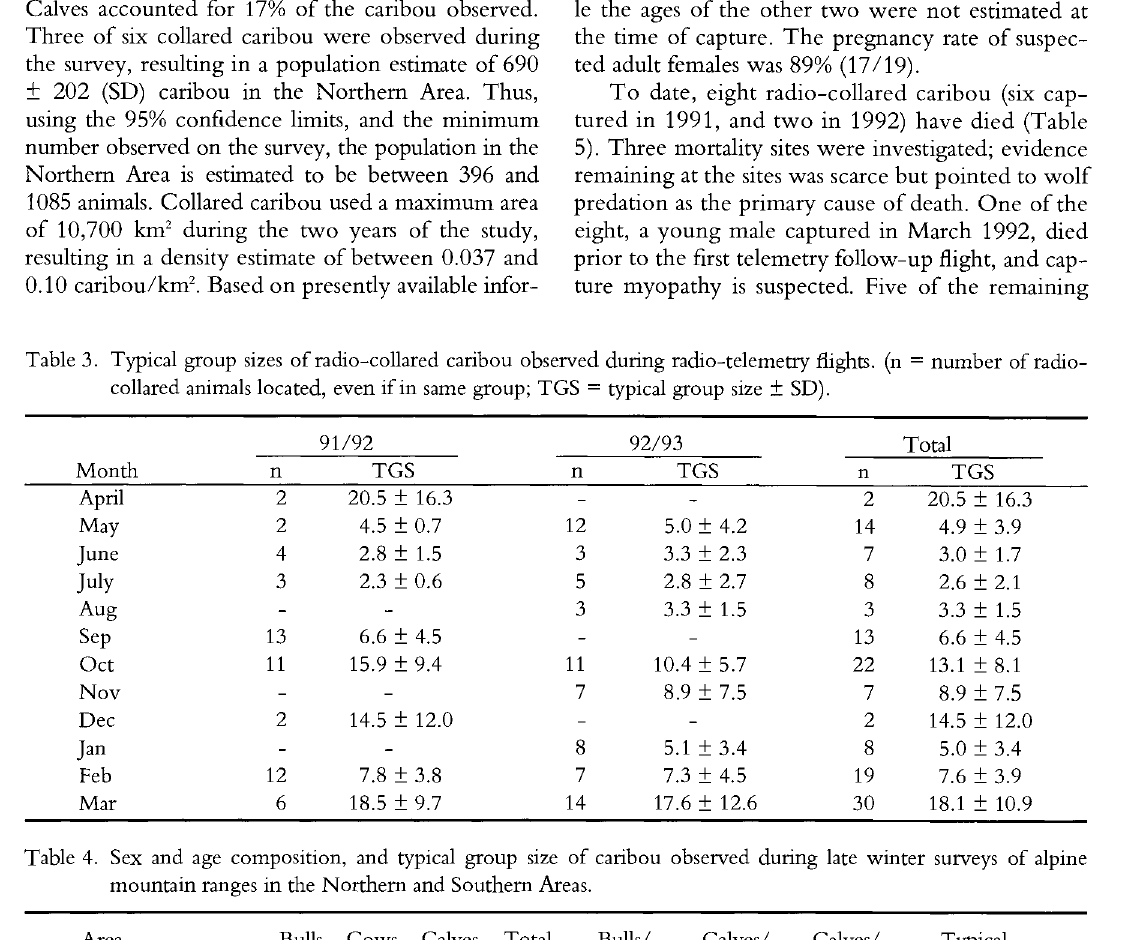
Table 4. Sex and age composition, and typical group size of caribou observed during late winter surveys of alpine mountain ranges in the Northern and Southern